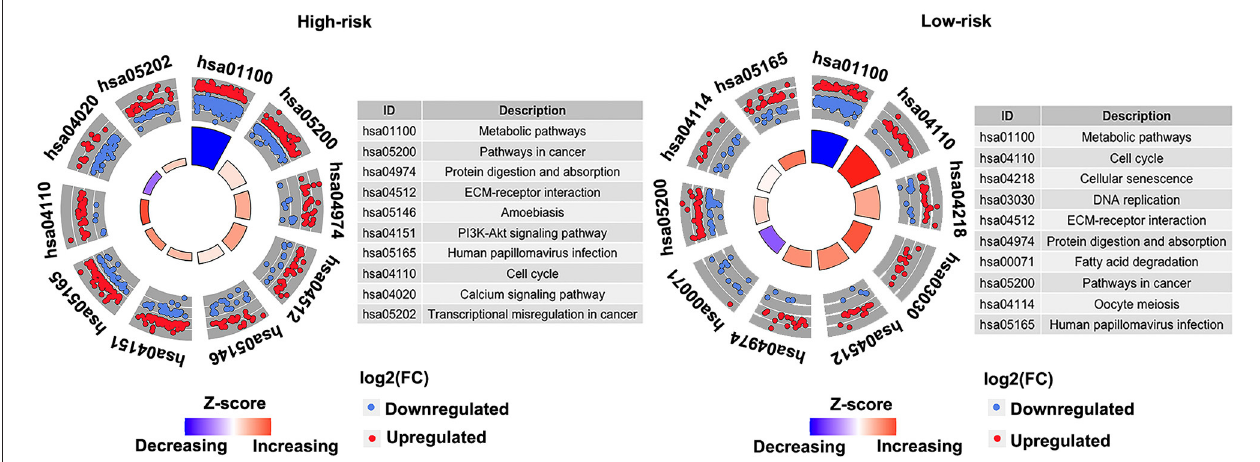
FIGURE 8 | Kyoto Encyclopedia of Genes and Genomes (KEGG) pathways enriched in the high- and low-risk groups in the discovery cohort (GSE53624). The outer circle shows a scatter plot for each term of the log2(FC) of the assigned genes. Red circles display upregulation, and the blue ones display downregulation. Left, high-risk. Right,